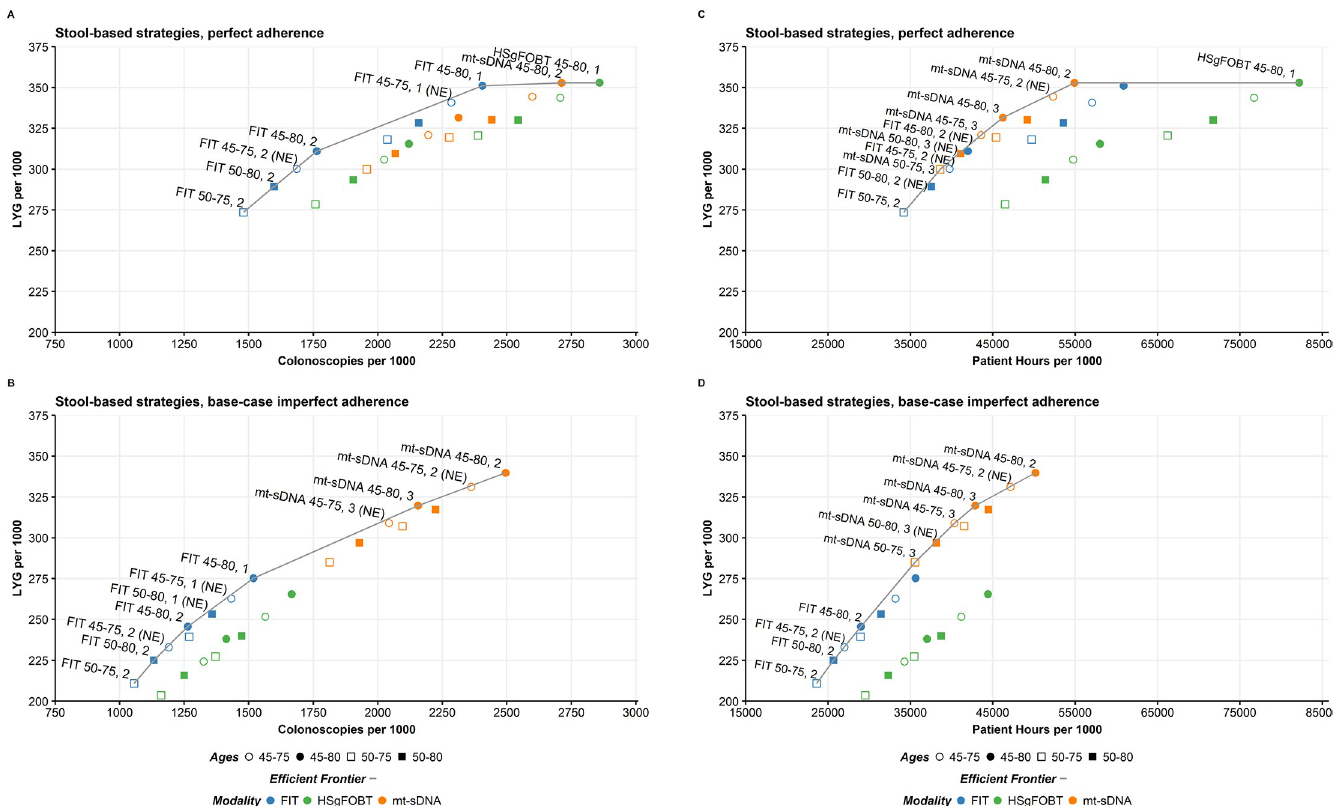
Fig 3. Life-years gained for individuals 40 years of age with stool-based tests by A) number of colonoscopies assuming perfect (100%) adherence or B) base-case imperfect adherence rates (40% FIT vs 34% HSgFOBT vs 70% mt-sDNA) and by C) patient hours related to the screening process assuming perfect (100%) adherence or D) base-case imperfect adherence (40% FIT vs 34% HSgFOBT vs 70% mt-sDNA). Results shown are per 1000 individuals free of diagnosed colorectal cancer at age 40 and screened starting at age 45 or 50 and ending at age 75 or 80 receiving biennial or triennial mt-sDNA, annual or biennial FIT, and annual or biennial HSgFOBT. NE,